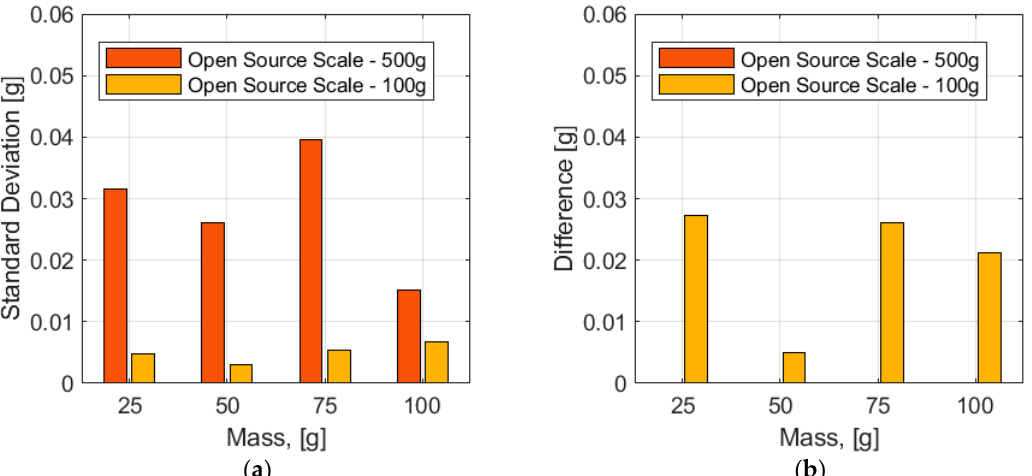
Figure 12. The 100 g load cell test results are shown. ( a ) The standard deviation (sample of 5 measurements) averaged to 0.005 g for the open-source scale. This is close to that of the lab-grade scales (on the same order as the APX402); ( b ) The absolute value of the difference between the average measurements by the 500 g TAL221 and the other two scales are shown. The 100 g TAL221 average measurement was within 0.0198 g of the 500 g TAL221, on average.